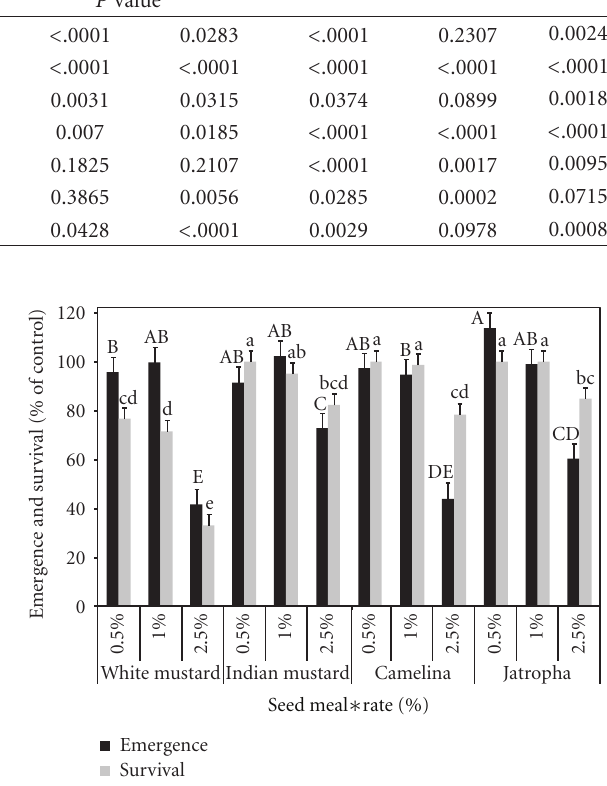
Table 2: ANOVA results for the main and interactive e ff ects of seed meal source, application rate, and incubation time on cotton, sorghum, Johnsongrass, and pigweed emergence (emerg), and survival (surv). SM denotes seed meal source. E ff ect